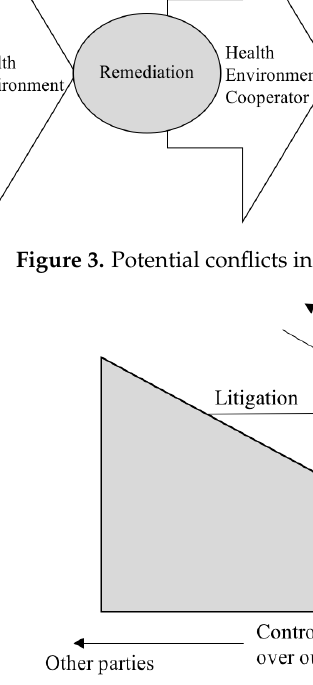
Figure 4. Features of dispute resolution methods (adapted from